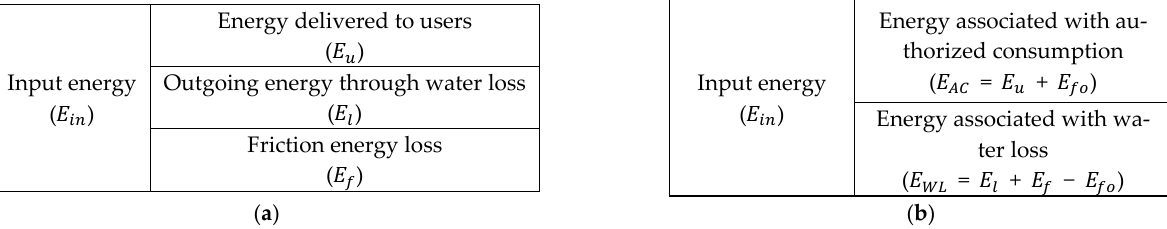
Figure 1. Two simplified energy balance concepts in water networks considering only leakage (as water loss) and pipe friction, where ( a ) is proposed by Cabrera et al. [10] and ( b ) is proposed by Mamade et al. [19–21].